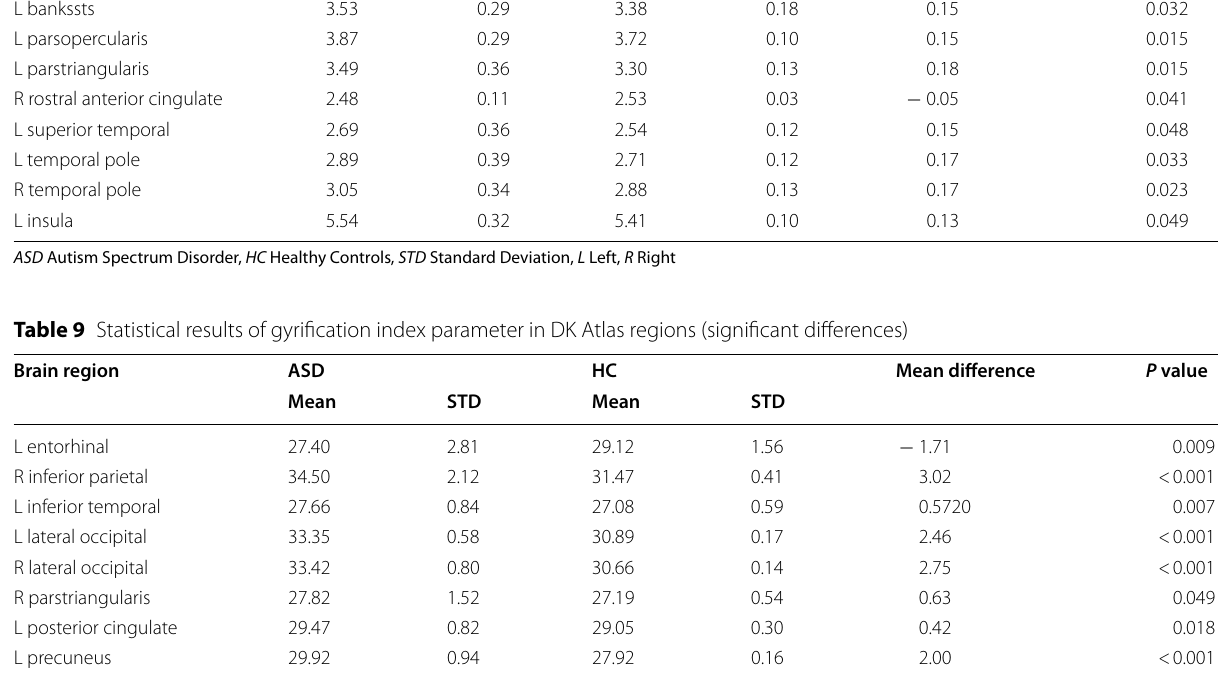
ASD Autism Spectrum Disorder, HC Healthy Controls, STD Standard Deviation, L Left, R Right Table 8 Statistical results of Sulcus depth parameter in Atlas DK areas (significant differences) Brain region